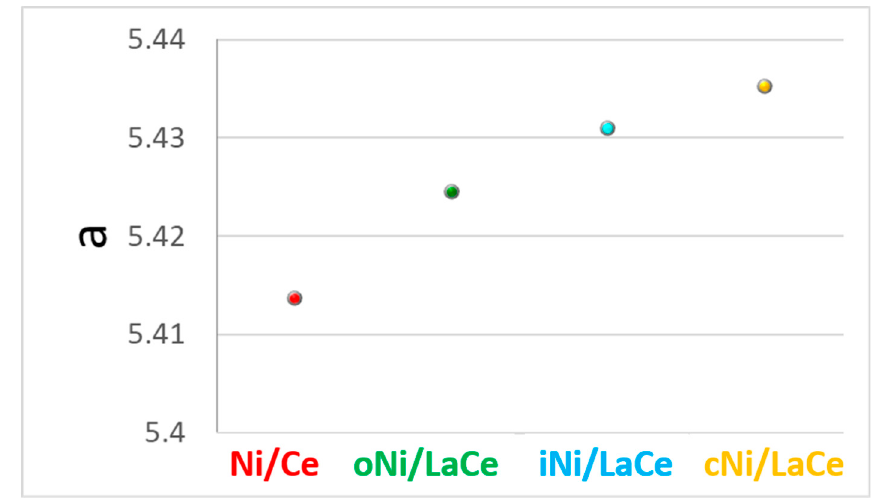
Figure 6. Variation of cell parameter of the catalysts obtained by Rietveld fit of XRD patterns.